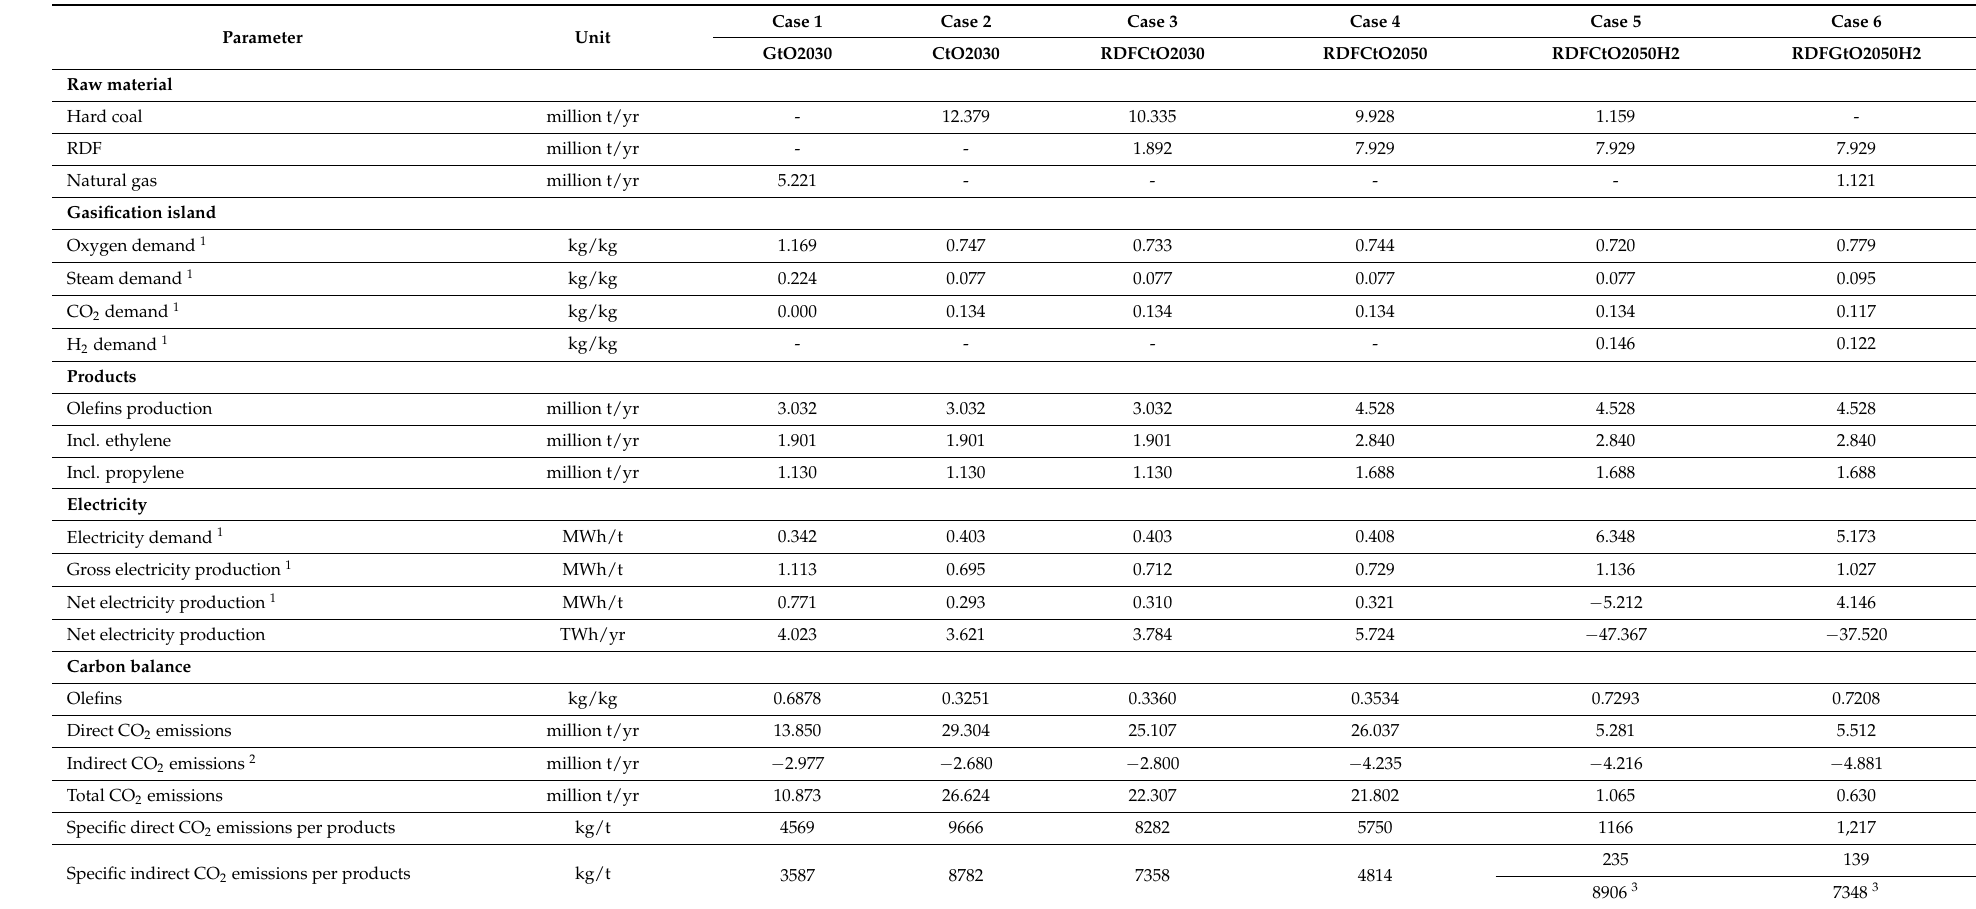
Table 9. Comparison of raw material and electricity usage, production capacity and main factors